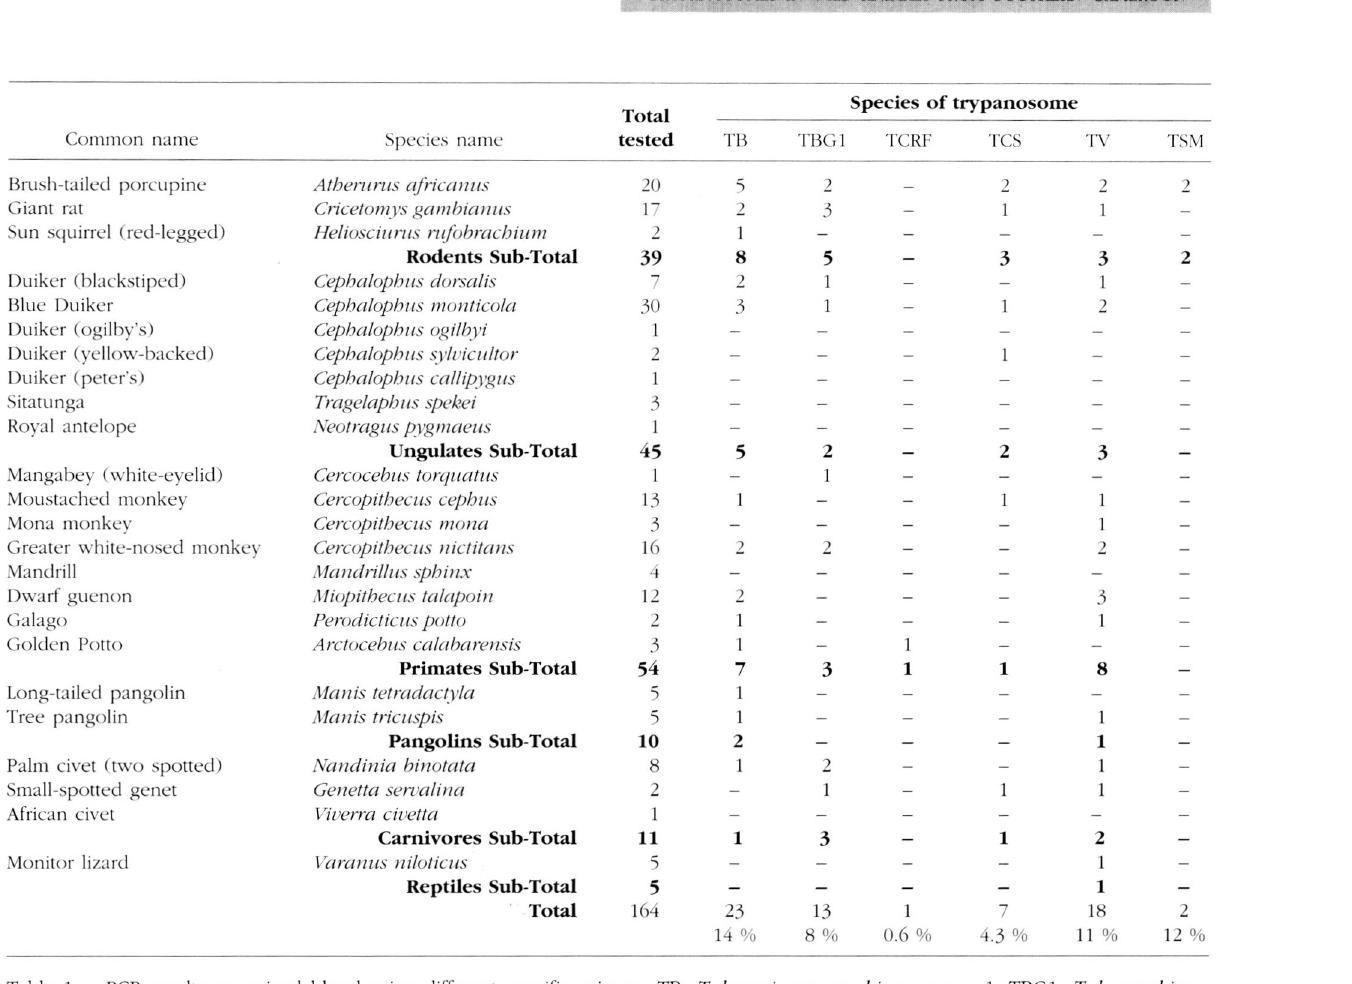
Table 1. - PCR results on animal blood using different specific primers. TB: T. brucei non gambiense group 1; TBGl: T. b. gambiense group 1; TCRF: T. congolense "forest type"; TCS: T. congolense "savannah type"; TV: T. vivax, TSM: 7*. simiae.